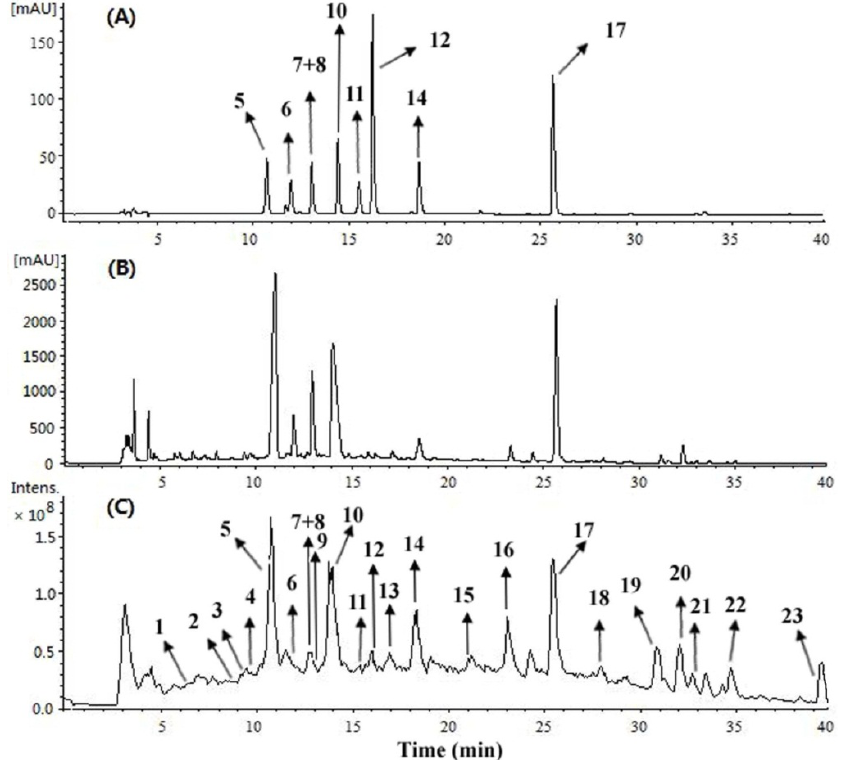
Figure 3. LC-UV/MS chromatograms for the alkaloid standards and the alkaloids-enriched extract of M. officinalis . ( A ) UV chromatogram at 283 nm of the nine alkaloid standards; ( B ) UV chromatogram at 283 nm and ( C ) MS TIC chromatogram of the alkaloids-enriched extract. Peak numbers were consistent with those shown in Table